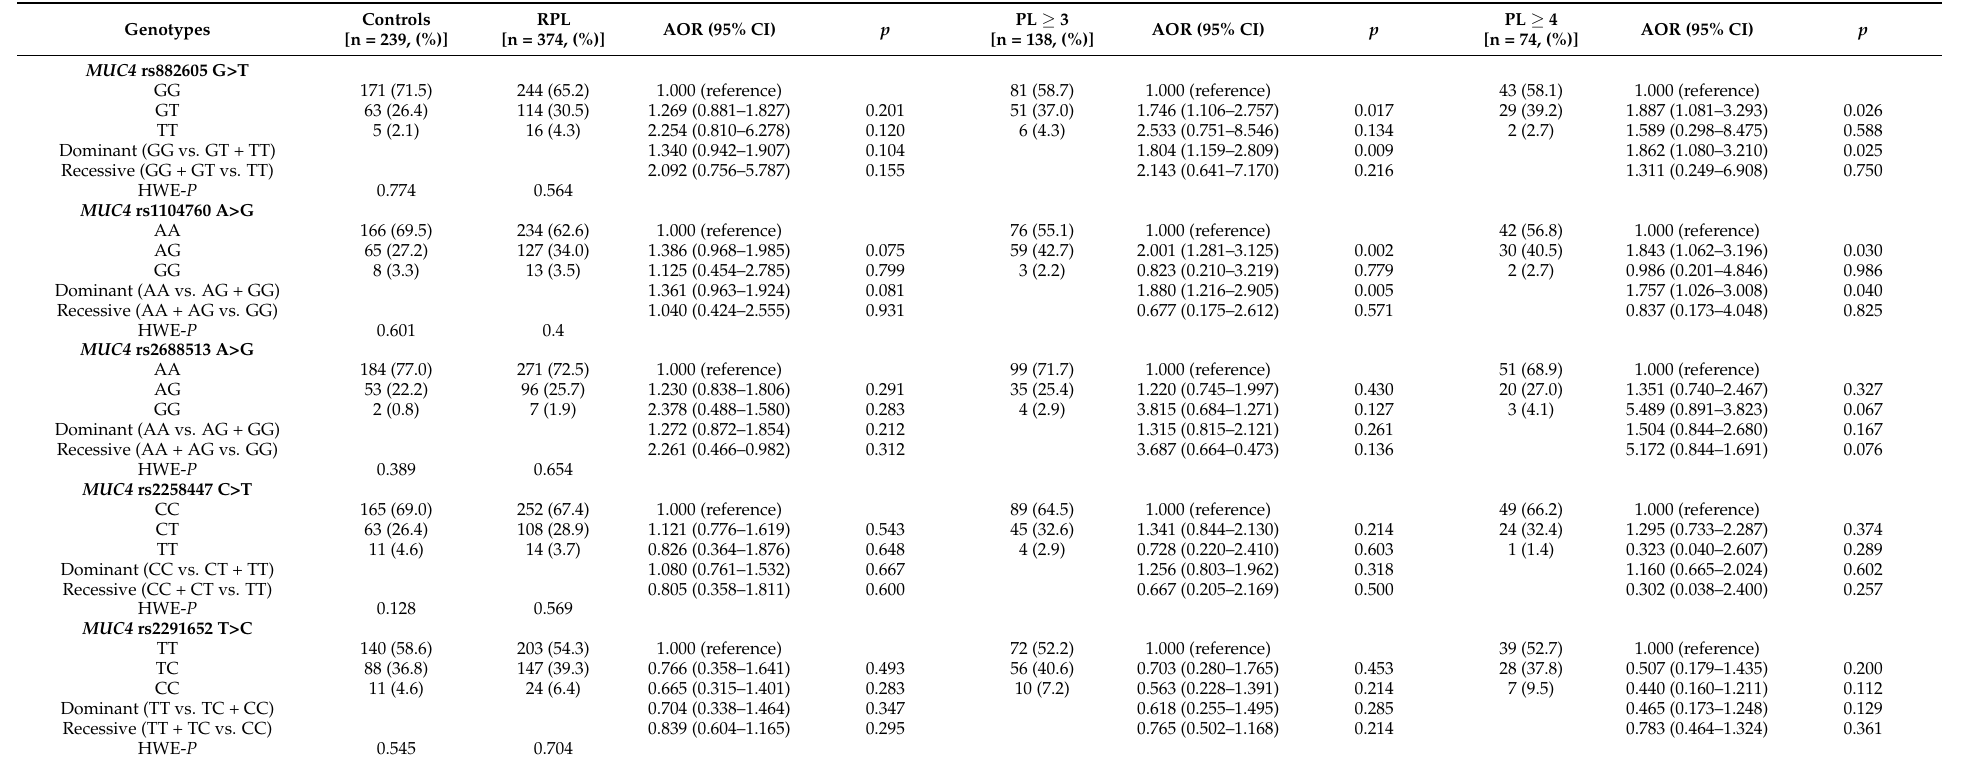
Table 2. The genotype frequencies of the MUC4 gene polymorphisms according to the number of recurrent pregnancy